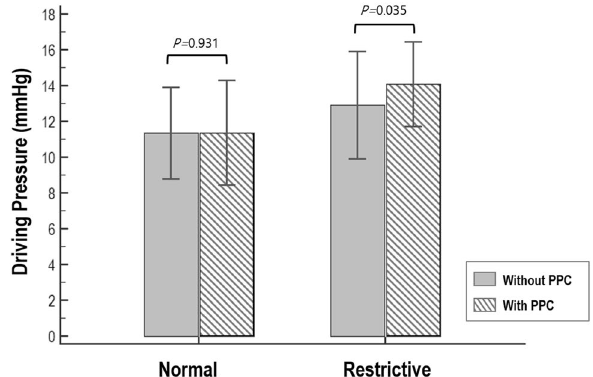
Figure 2. The association between intraoperative driving pressure and postoperative pulmonary complication (PPC) in the subgroup of patients with normal preoperative spirometry and in the subgroup of patients with restrictive preoperative